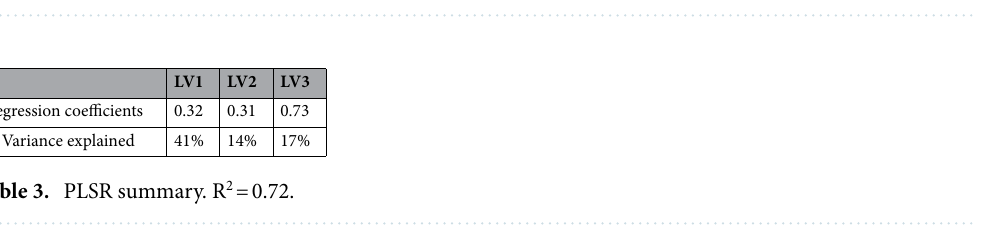
Table 2. Summary of the elements selected as predictors (mg kg −1 ).